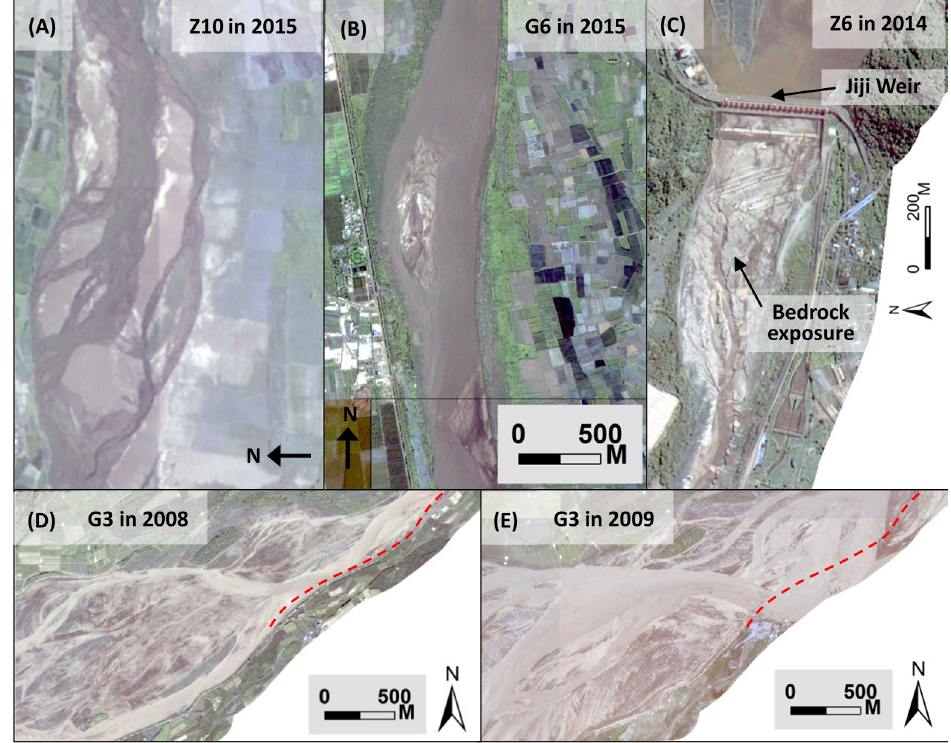
Figure 8. Satellite images: ( A ) the braided channels in reach Z10; ( B ) a single/wandering channel in G6; ( C ) bedrock exposure downstream of the Jiji Weir; ( D ) braided channels before Typhoon Morakot in G3; and ( E ) channel expansion and embankment breaking after Typhoon Morakot.